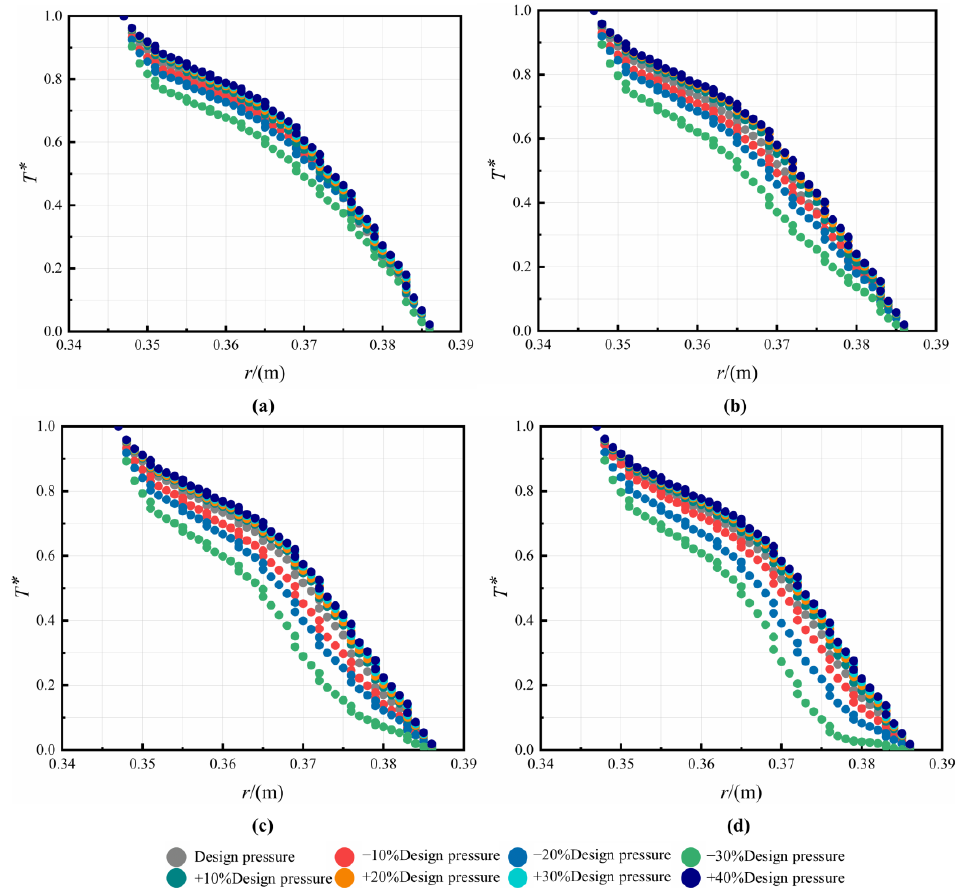
Figure 17. Radial distribution of non-dimensional temperature in C3 cavity for different Re : ( a ) Re = 2.3793 × 10 5 , ( b ) Re = 4.7586 × 10 5 , ( c ) Re = 7.1379 × 10 5 , and ( d ) Re = 9.5172 × 10 5 .